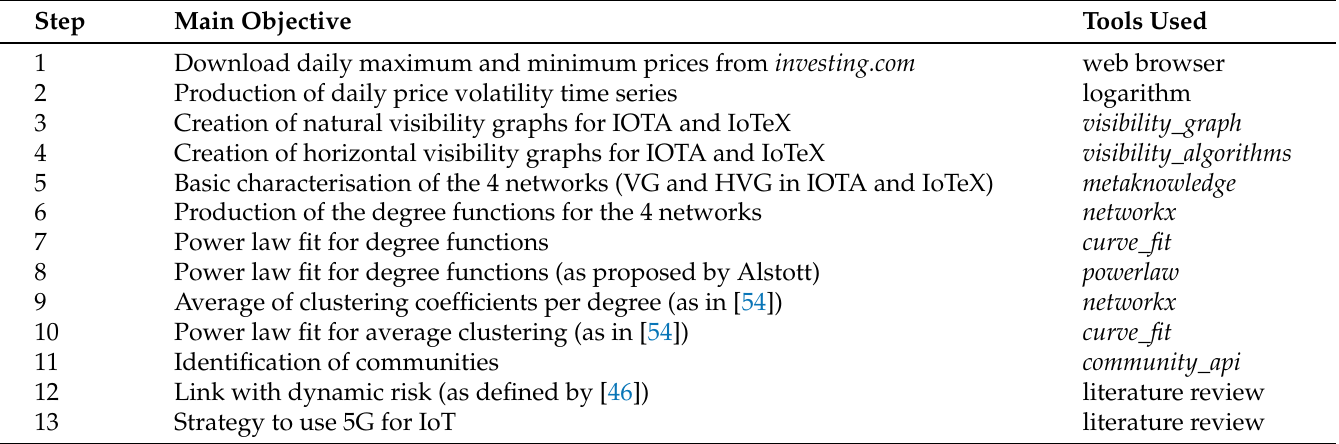
Table 8. Summary of the methodology with steps, objectives and